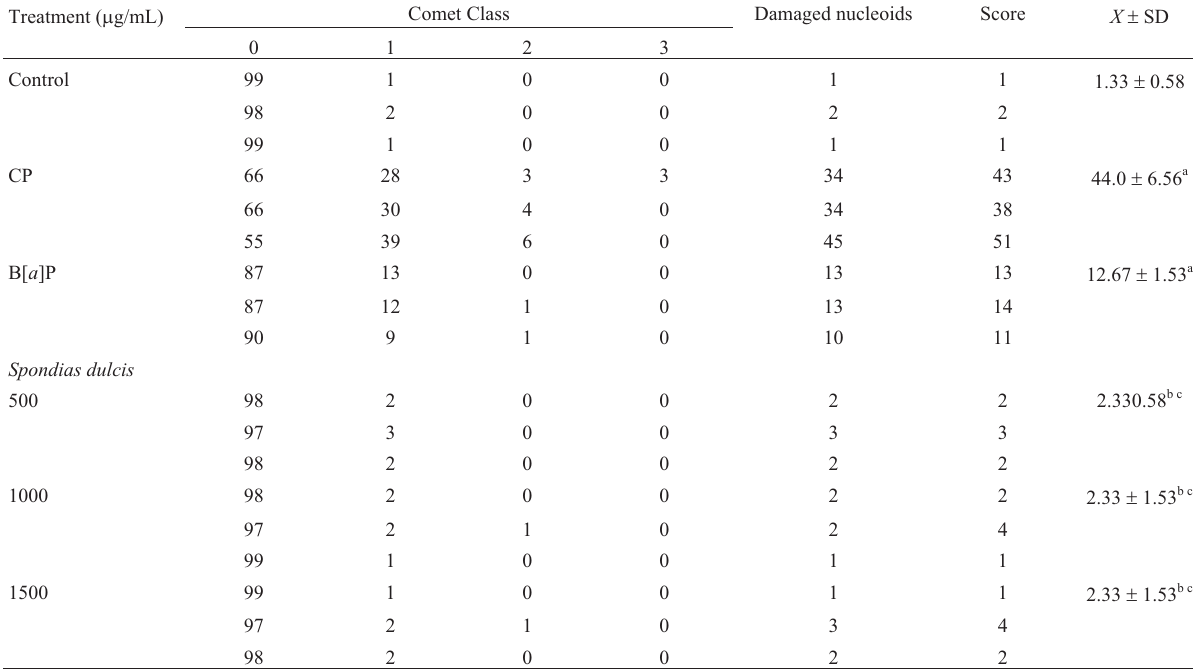
Table 2 - Number of nucleoids observed in each comet class in 300 cells analyzed per treatment, and their respective mean scores when assessing the genotoxicity of Spondias dulcis at three different concentrations in mice. Treatment ( (cid:3) g/mL)